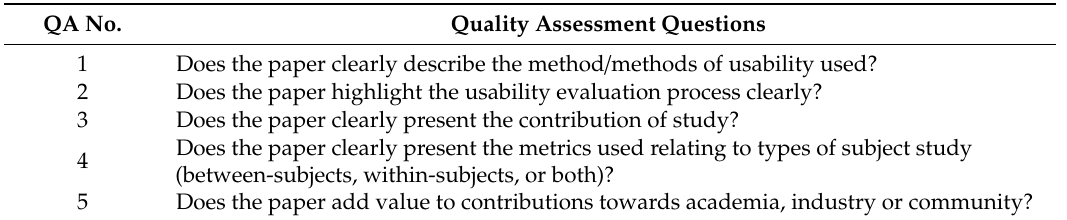
Table 3. Quality assessment